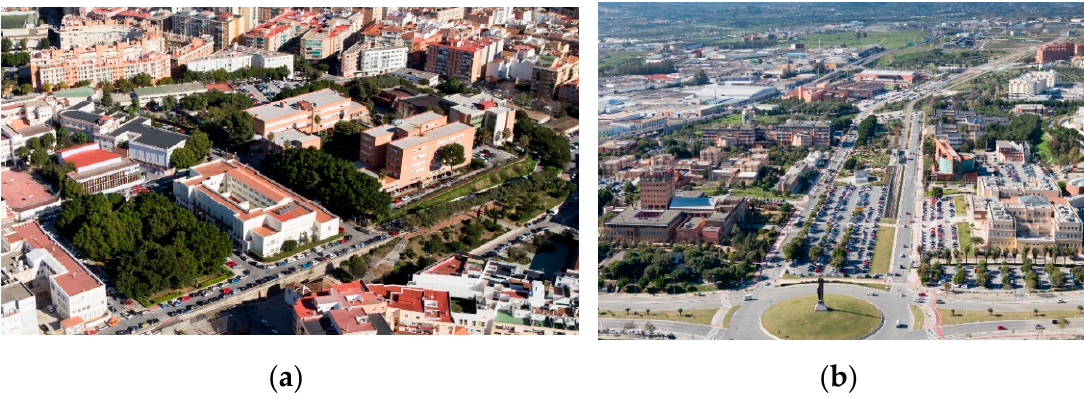
Figure 1. Captures of the section of the campus located at the city center ( a ) and the Teatinos Campus ( b ) [16].